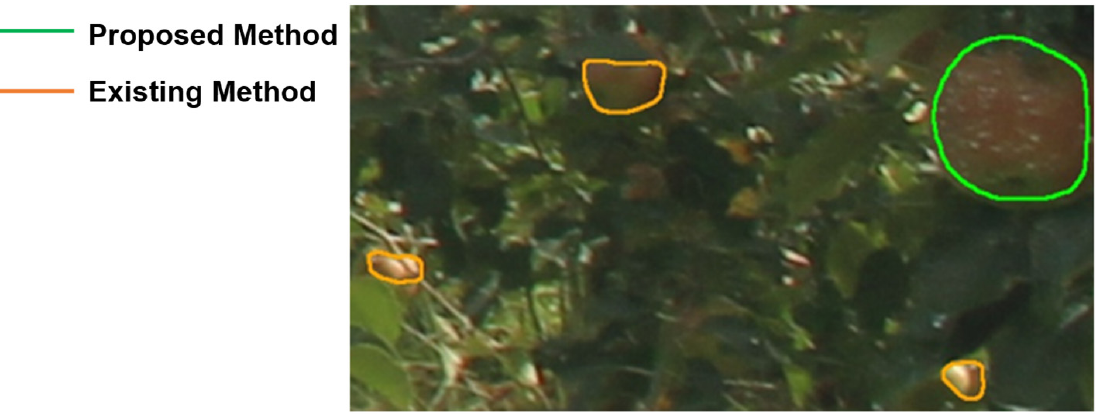
Figure 11. Example of small fruit detection. The proposed model outperformed the COCO learning model in mean and median IoU because it could accurately detect hidden regions of fruit without detecting parts of the fruit. The orange line is the result of the COCO as an existing method, and the green line is the result of the proposed method.